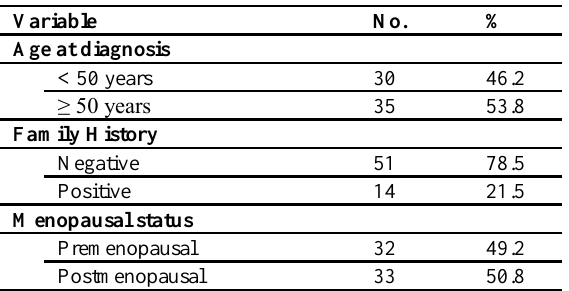
Table 1: Patients’ characteristics (n= 65)